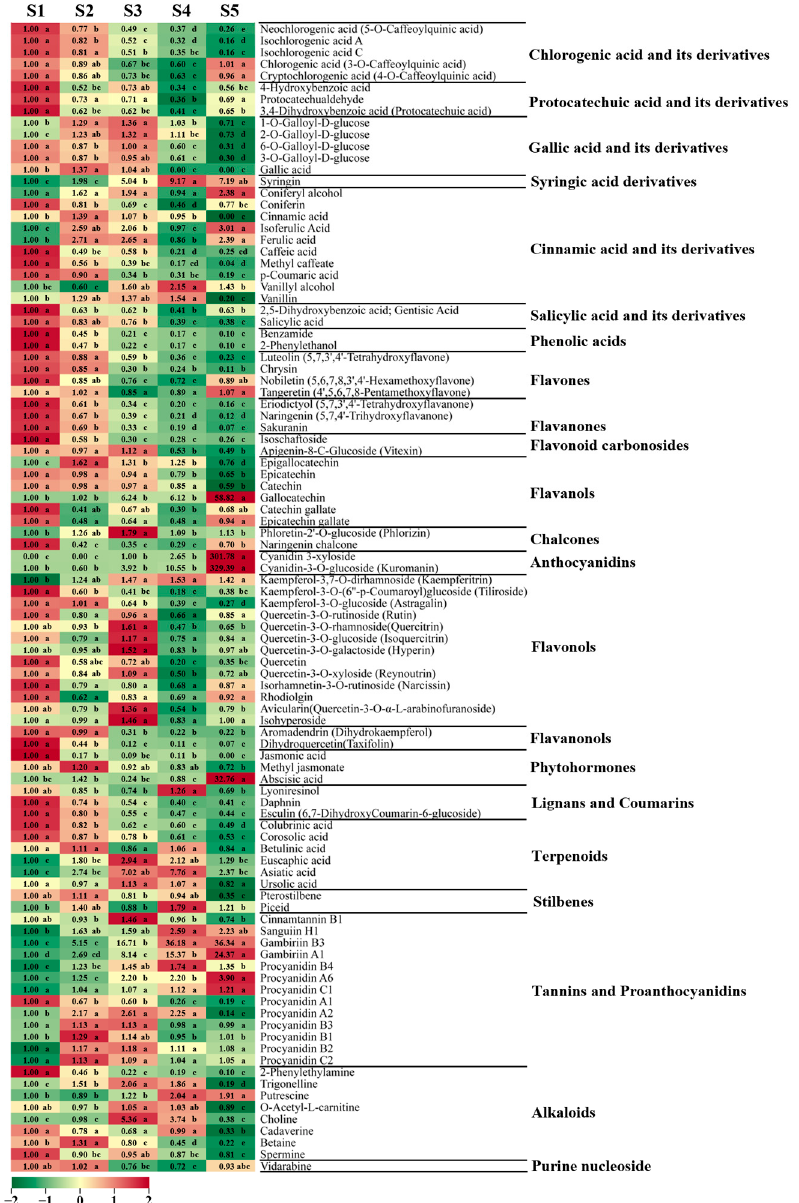
Figure 6. Representative secondary metabolites detected through broadly targeted metabolomic analysis during the five periods of fruit development. Ploidy changes for each metabolite across these five periods are depicted in heat map format. Significance analysis was performed using SPSS software with Tukey’s test and using a threshold of p < 0.05, the results are indicated by lowercase letters a, b, c, d, and e in the figure.